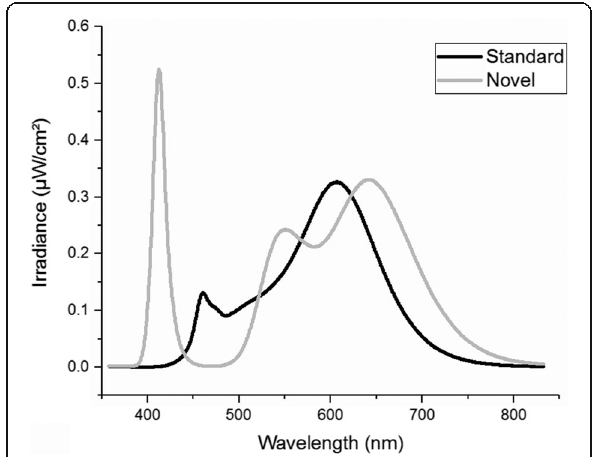
Fig. 1 Spectral output of the blue-depleted (grey) and standard (black) white LED lamps. Irradiance was measured with a research spectroradiometer (ILT-900R, International Light Technologies, Peabody MA)